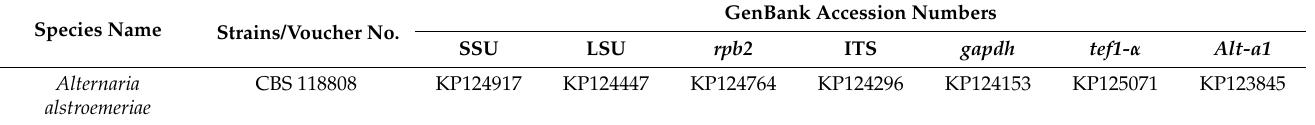
Table 1. Taxa used for the phylogenetic analyses in this study and their GenBank accession numbers. The ex-type cultures are indicated with superscript “ T ” and the newly generated sequences are indicated in